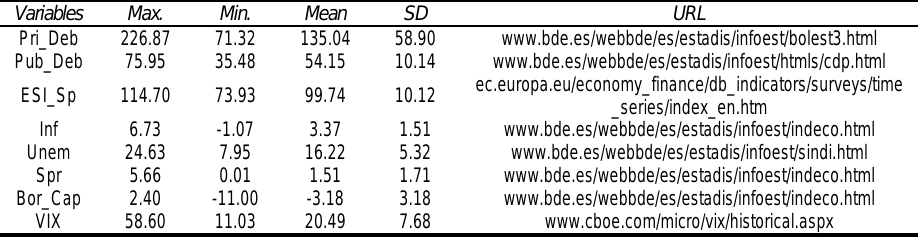
Table 1. Descriptive statistics and data sources